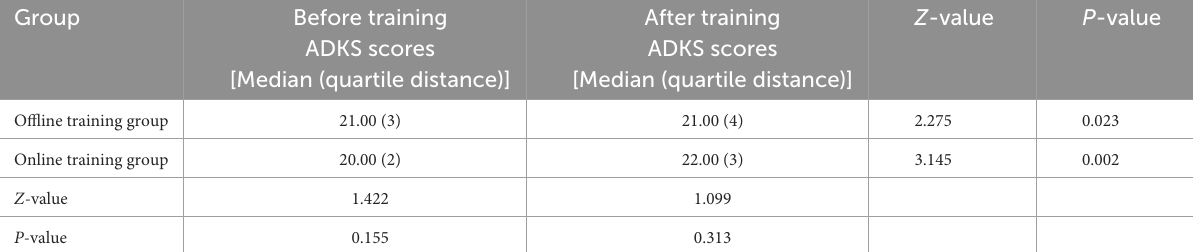
TABLE 5 ADKS scores before and after